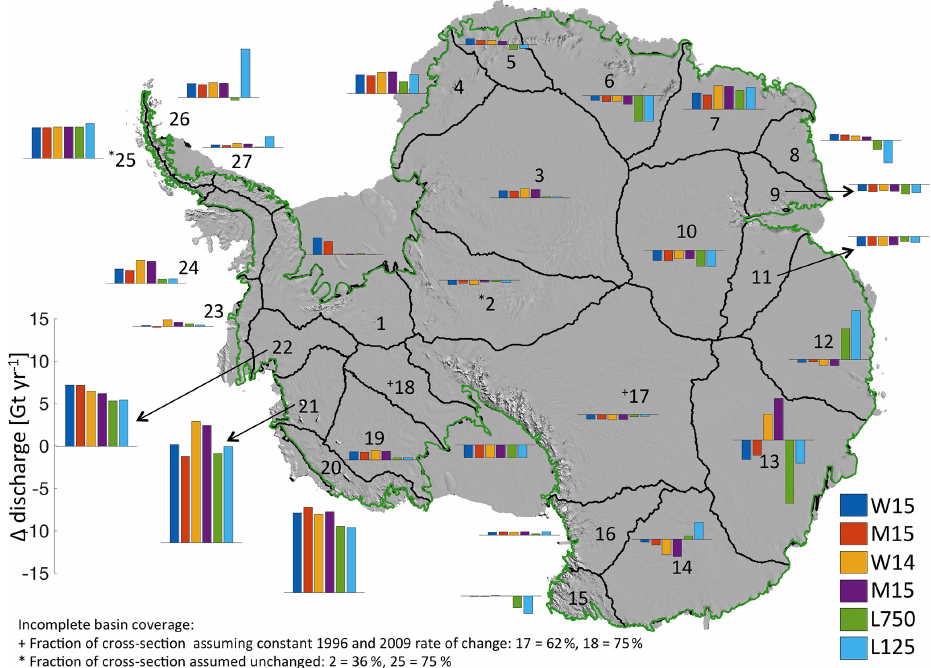
Figure 7. Change in flux across FG1 flux gate (shown with green line; see Methods) for the 27 basins defined by Zwally et al. (2002) calculated by differencing the pan-Antarctic SAR mapping of Rignot et al. (2011a, circa 2008) with six different Landsat 8 velocity mappings (M14/15 = JPL median of all 2014/15 image pairs; W14/15 = JPL weighted average of all 2014/15 image pairs; L750 = NSIDC 750m average of all 2014–2015 image pairs; L125 = NSIDC 125m average of all 2014–2015 image pairs). Basins 2, 17 and 18 are complimented with differences in 1997 and 2009 SAR velocities poleward of 82.5 ◦ S (Scheuchl et al., 2012). Much of the difference between velocity mappings can be attributed to product errors. W15 has the lowest uncertainties (used in this study), followed by M15, then W14 and M14, with the LISA products having the highest uncertainties (See Fig.